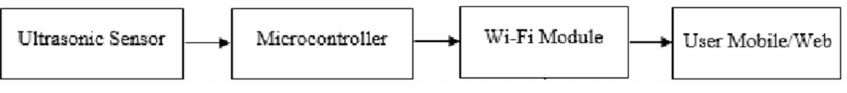
Figure 2. Working flow of the designed system.